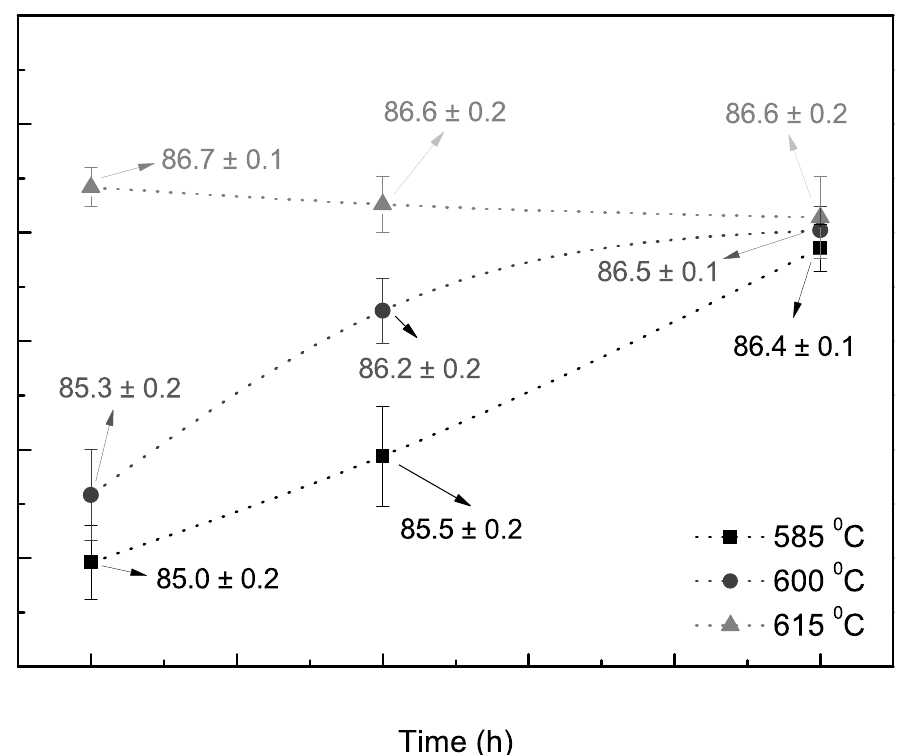
Figure 3. Densification for different temperatures and sintering times, obtained using the Archimedes method.